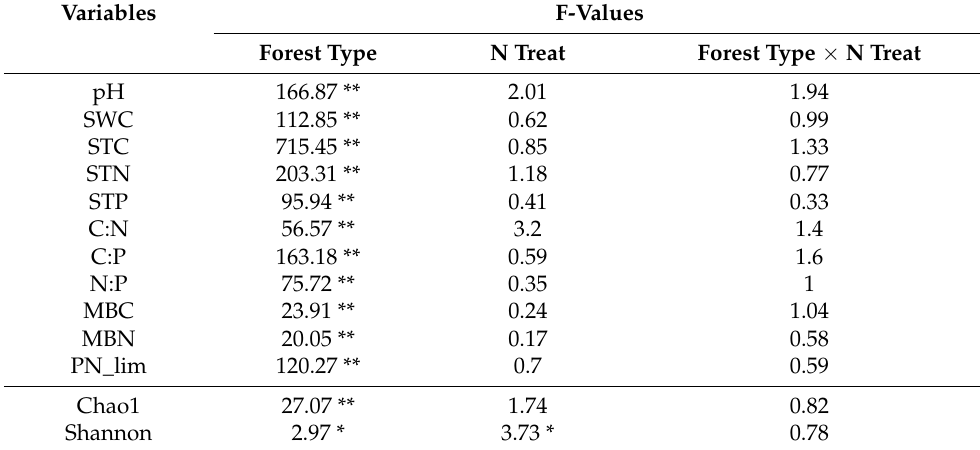
Table 2. Effects of forest types, N treatments, and their interaction on variables (i.e., soil properties and fugal diversity) based on two-way analyses of variance (ANOVAs). Level of significance: * p < 0.05, ** p <